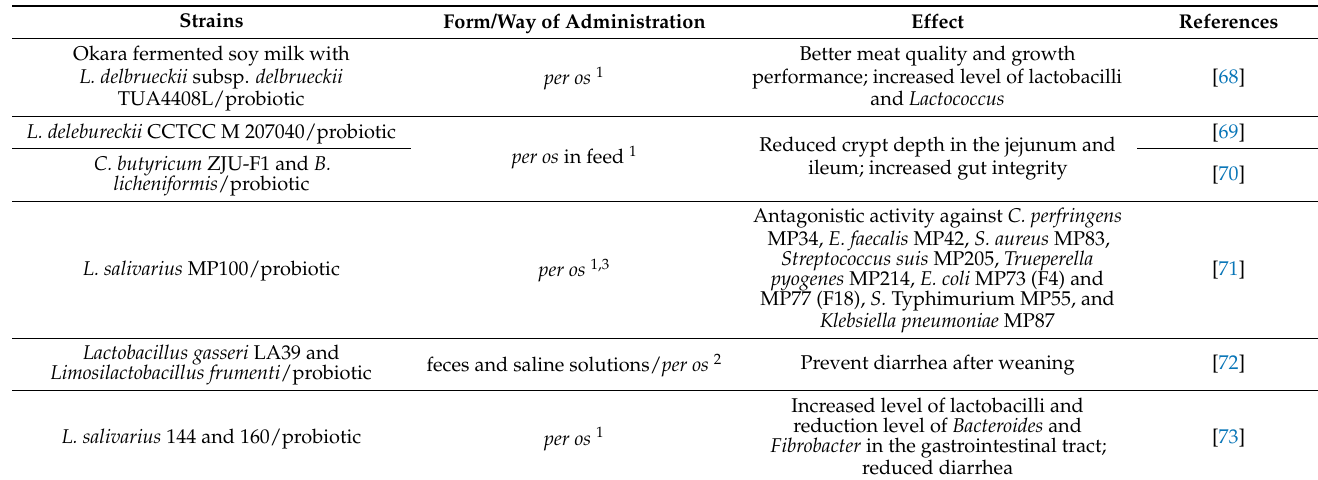
Table 2. Overview of the application of beneficial bacteria in pig and piglet farming in an in vivo study.